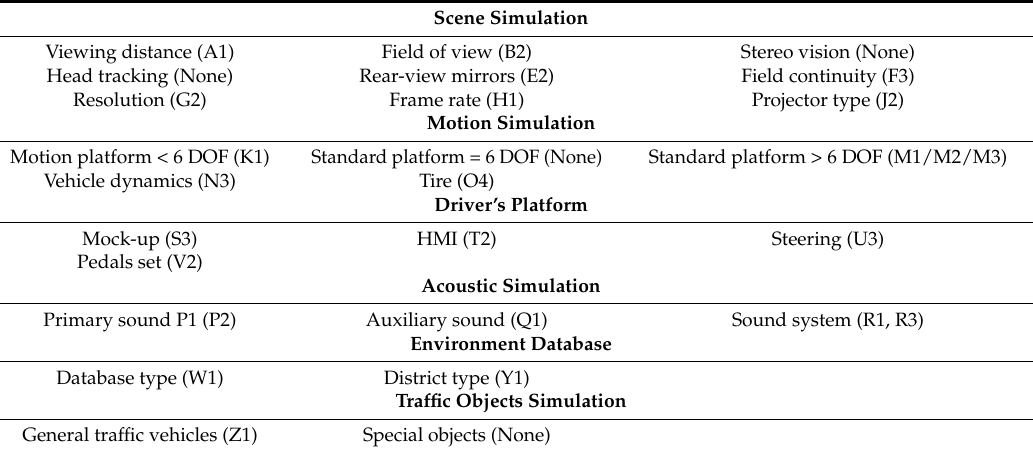
Table 2. Profile of driving simulator application class 1a